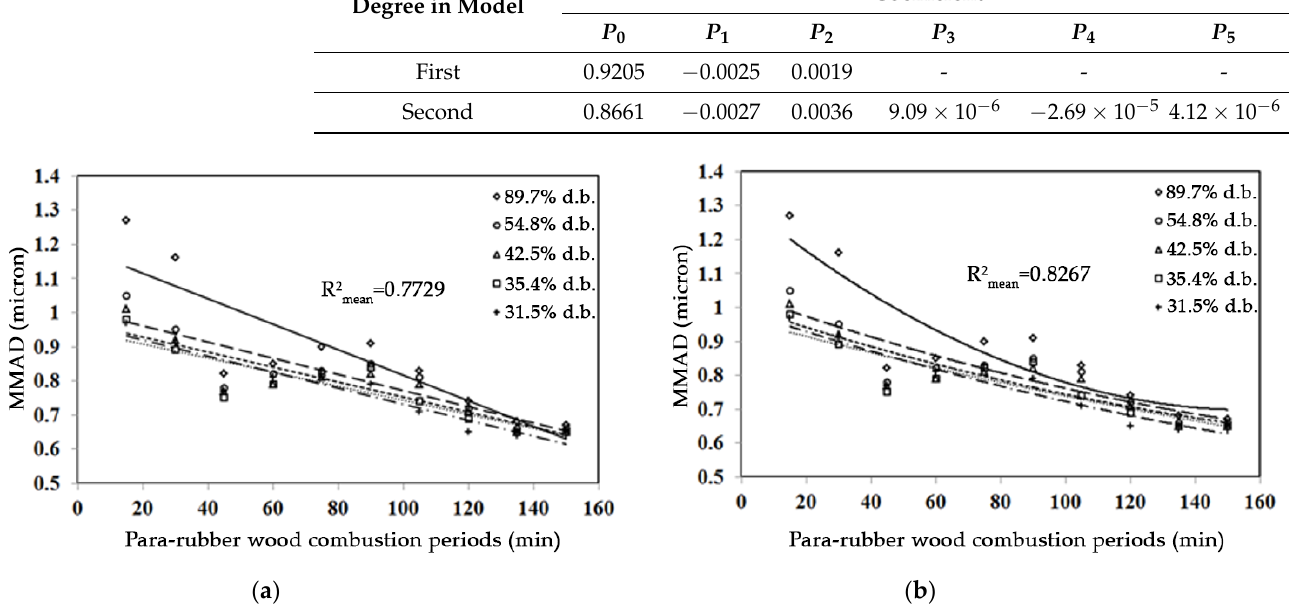
Figure 6. MMAD values ’ 3D surface plots by the first- and second-degree models: ( a ) First-degree model; ( b ) Second- degree model.